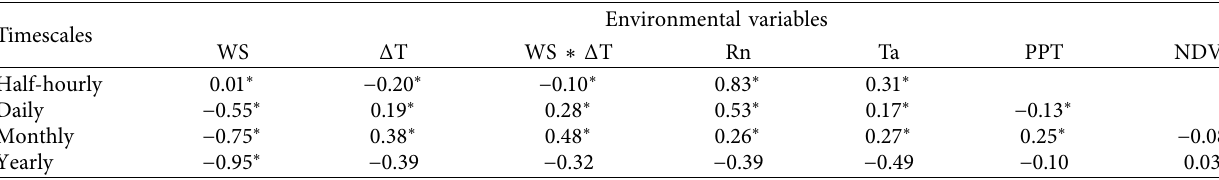
Table 4: Correlation coefcients of the averaged sensible heat fux (Hs) and environmental variables including the averaged wind speed (WS) at 4m height, temperature diference between the upper soil layer (at 4 cm depth) and the atmosphere ( Δ T), the WS multiplied by Δ T (WS ∗ Δ T), net radiation (Rn) at 1.5m height, air temperature (Ta), the total precipitation (PPT), and the normalized diference vegetation index (NDVI) at multiple timescales from 2007 to 2018. Tere is no examination about the PPT at half-hourly timescales and the NDVI between half-hourly and daily